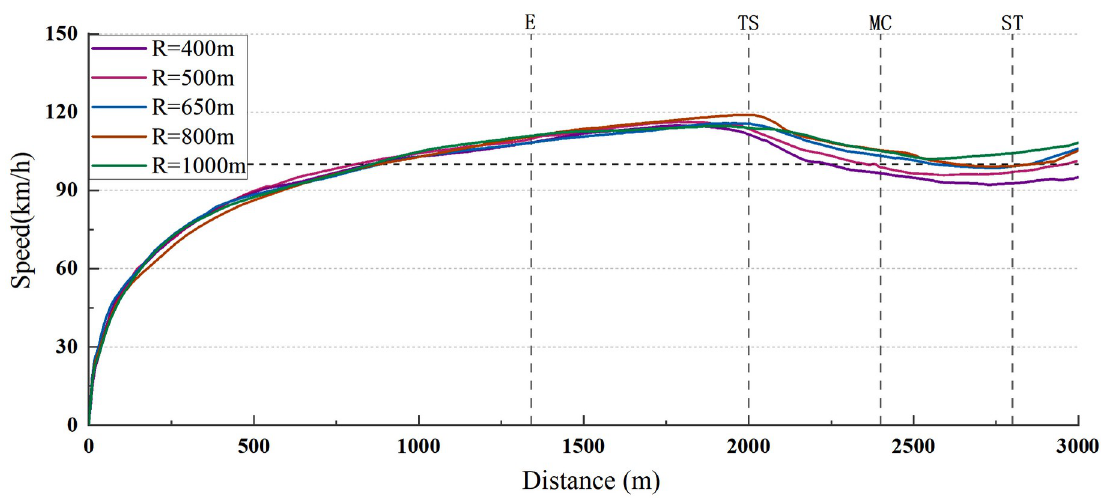
Fig 12. Drivers’ actual speed on single curves (mean value) (The horizontal dotted reference line indicates that the speed limit is 100 km/h; the four longitudinal reference lines correspond to the perceived speed acquisition points: E, TS, MC, and ST).